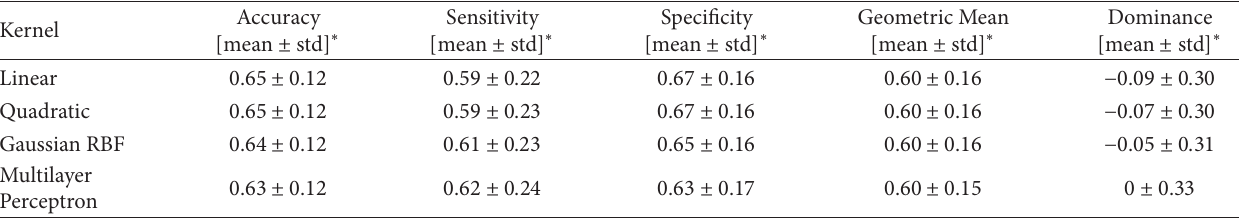
∗ Averaged across 10 rounds of the nested CV and across 100 iterations.